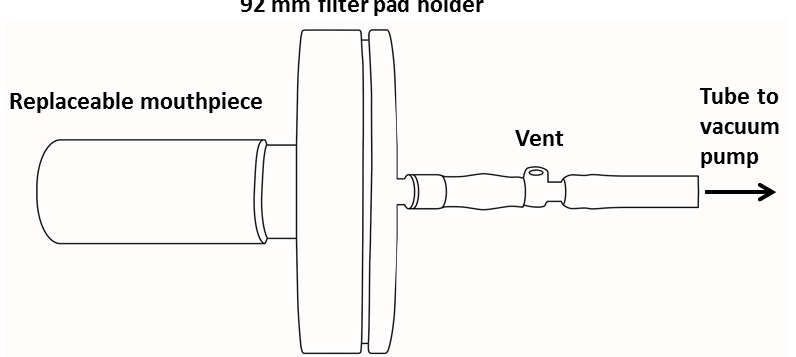
Figure 2. Schematic of the vacuum-assisted collection system for exhaled